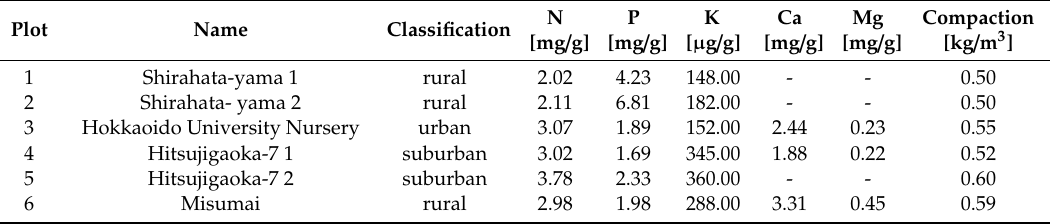
Figure 3. Sample sites of Abies sachalinensis within the city of Sapporo; the symbols * denotes approximately the locations of climate stations across Sapporo. Table 2. Characteristics and soil chemical structure (nitrogen N, available phosphorus P content by the Bray ll method, potassium K, calcium Ca and magnesium Mg) at a depth of 10–20 cm, as well as bulk density of sample plots within Sapporo and its